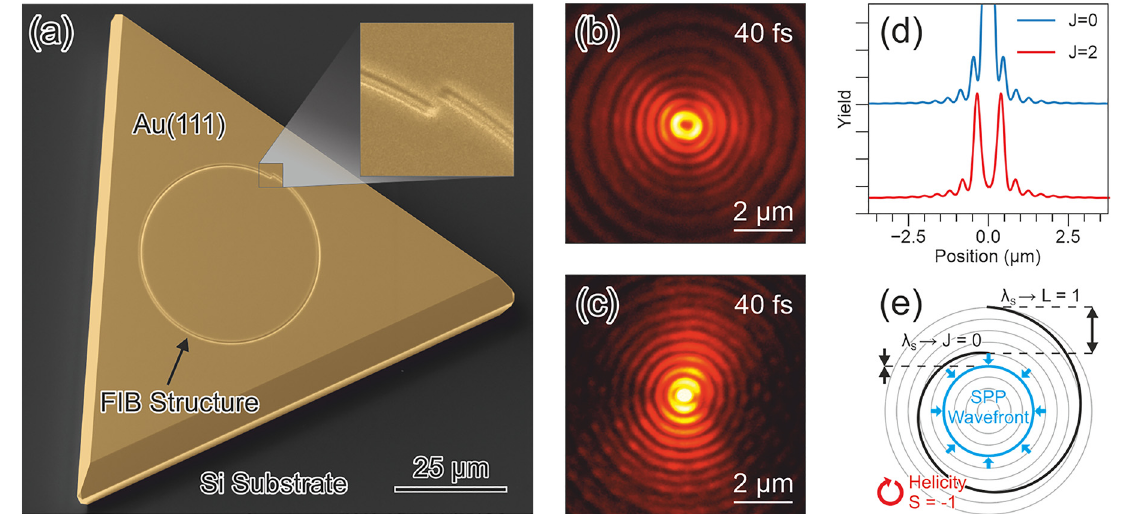
Figure 1: (a) Au island with an Archimedean spiral milled into it. The inset shows the gap of one SPP wavelength ( L = 1). (b) Logarithmically scaled PEEM image of the center of the spiral for excitation with S = 1 circularly polarized light yielding a ‘‘doughnut’’ mode with J = 2. (c) Logarithmically scaled PEEM image for excitation with S = − 1 circularly polarized light yielding a focus spot in the center of the spiral with J = 0. (d) Azimuthally-averaged photoemission yield extracted from panels (b) and (c) in linear scaling showing the strong enhancement of the emission in the center ( J = 0, blue) and in the ring comprising the doughnut ( J = 2, red). The curves are vertically shifted with respect to each other. (e) Illustration of the focus formation. As the field orientation in the surface plane rotates clockwise within each optical cycle, SPPs are excited at different locations along the groove. For S = − 1 helicity, SPPs excited at earlier times propagate longer to the center of the spiral. In the center all SPPs interfere